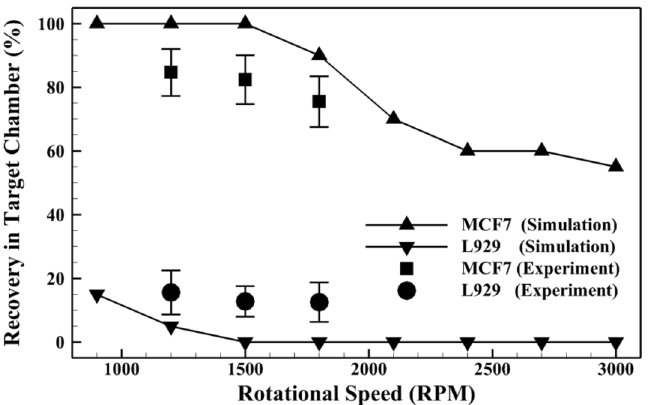
Figure 10. Numerical and experimental recovery rates of MCF-7 and L929 cells from the target chamber of the hybrid design of